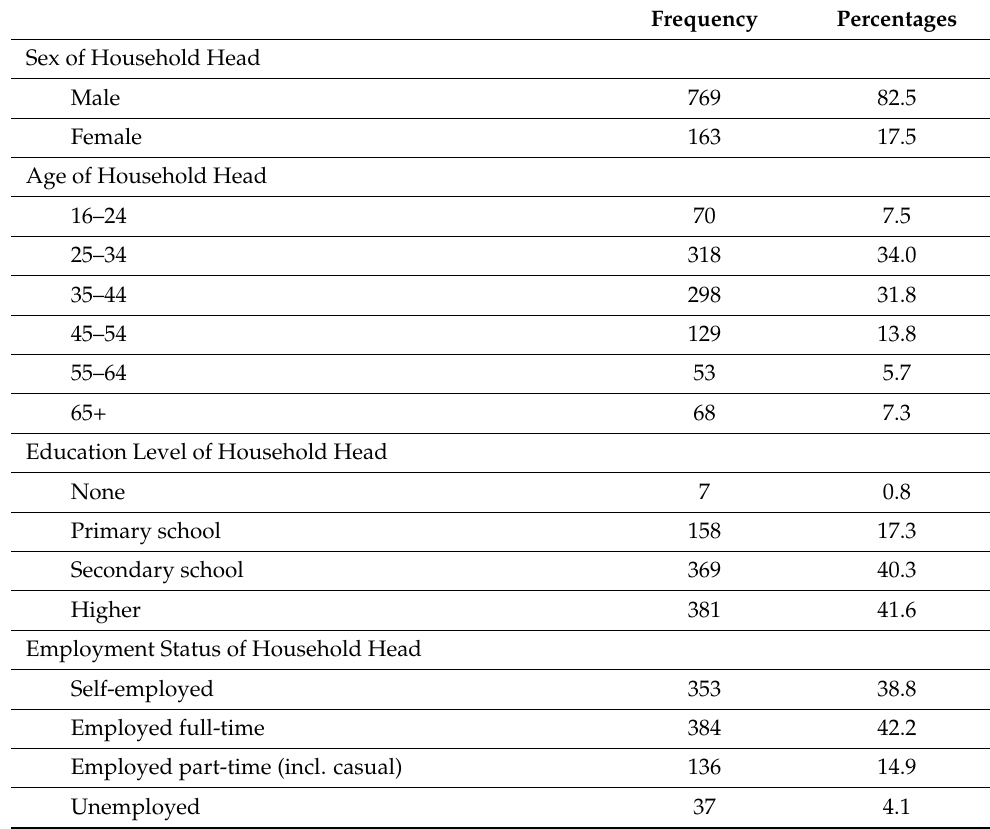
Table 4. Migrant household